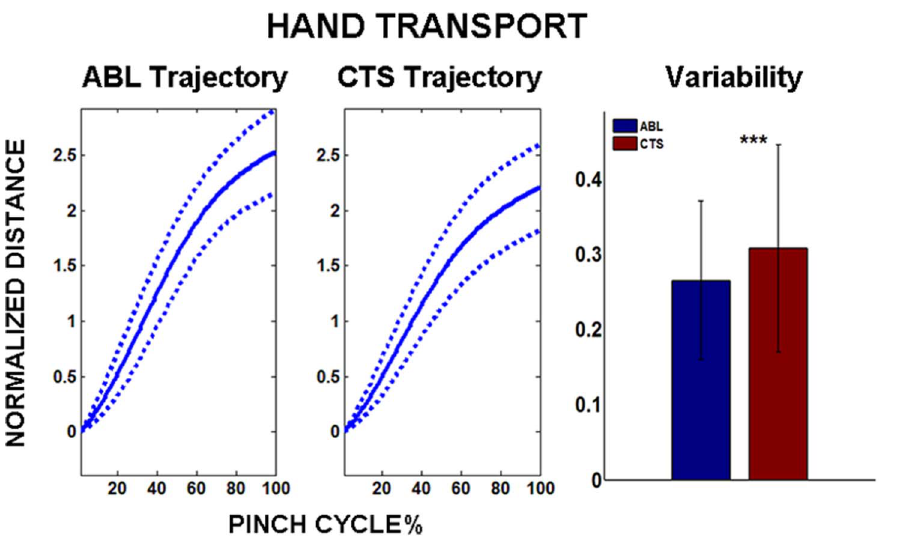
Figure 6. Hand transport accumulated over pinch cycle. LEFT: Hand transport for ABL and CTS subject groups. Solid line denotes mean trajectory, and dotted line denotes variability ( 6 1 s.d.) about mean trajectory. RIGHT: Comparing variability between ABL and CTS groups. Note: ***p , 0.001, Distances self-normalized by subject ‘‘palm width’’.